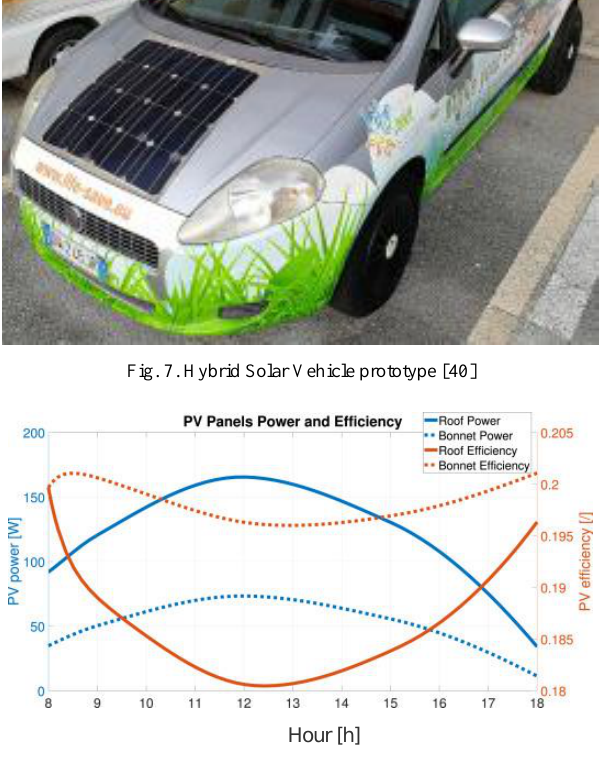
Fig. 8 Power and efficiency of the PV panels during parking on August 5th [40]